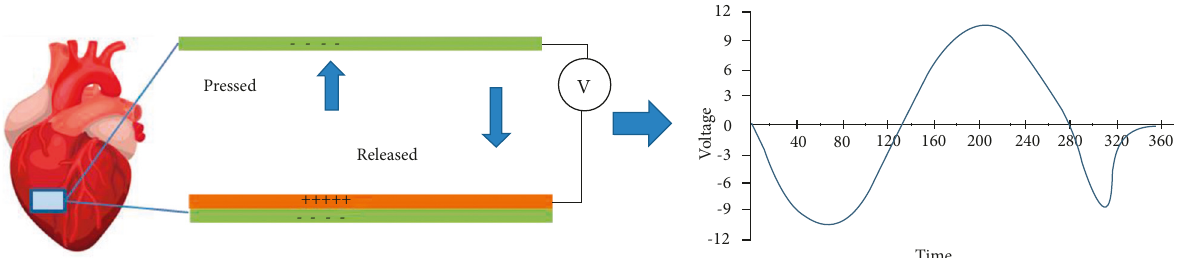
Figure 5: A schematic illustration of the respiratory implantable monitoring system.